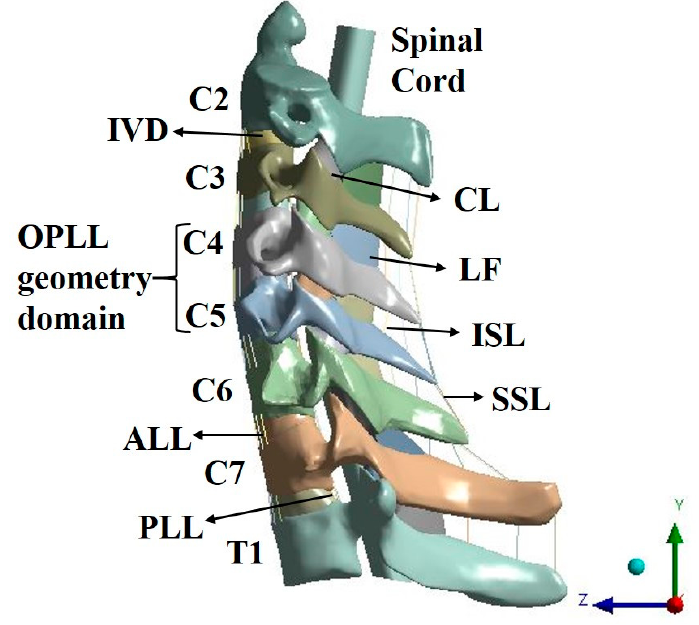
Figure 1. Three-dimensional cervical spine model.